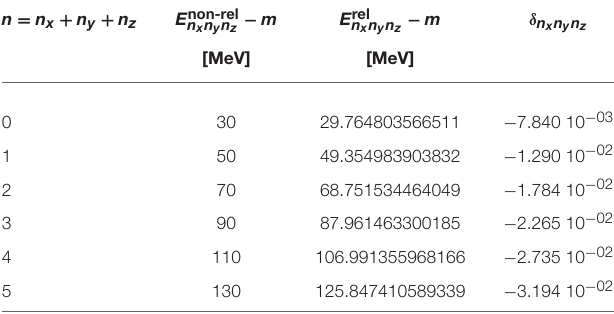
TABLE 1 | Energies of the lowest eigenstates of a spherically symmetric harmonic oscillator with - h ω 20 MeV and m 938 MeV/ c 2 in the non-relativistic and = = relativistic case and relative difference